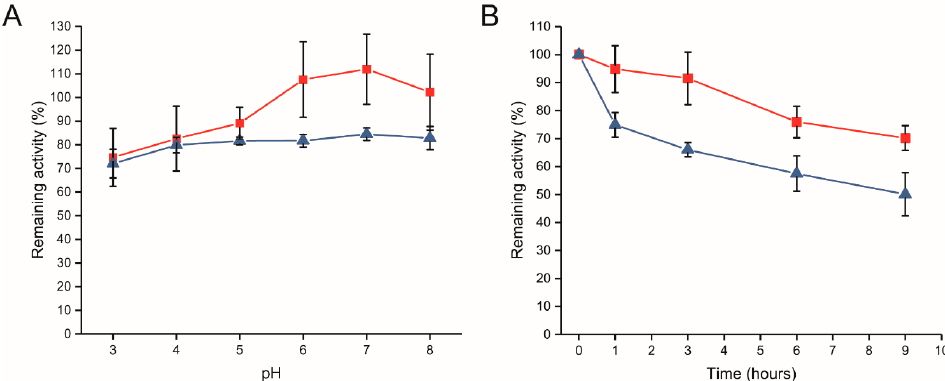
Figure 4. Effect of ( A ) pH and ( B ) temperature on the stability of free (blue line) and CLEAs R483A-LrInu (red line).